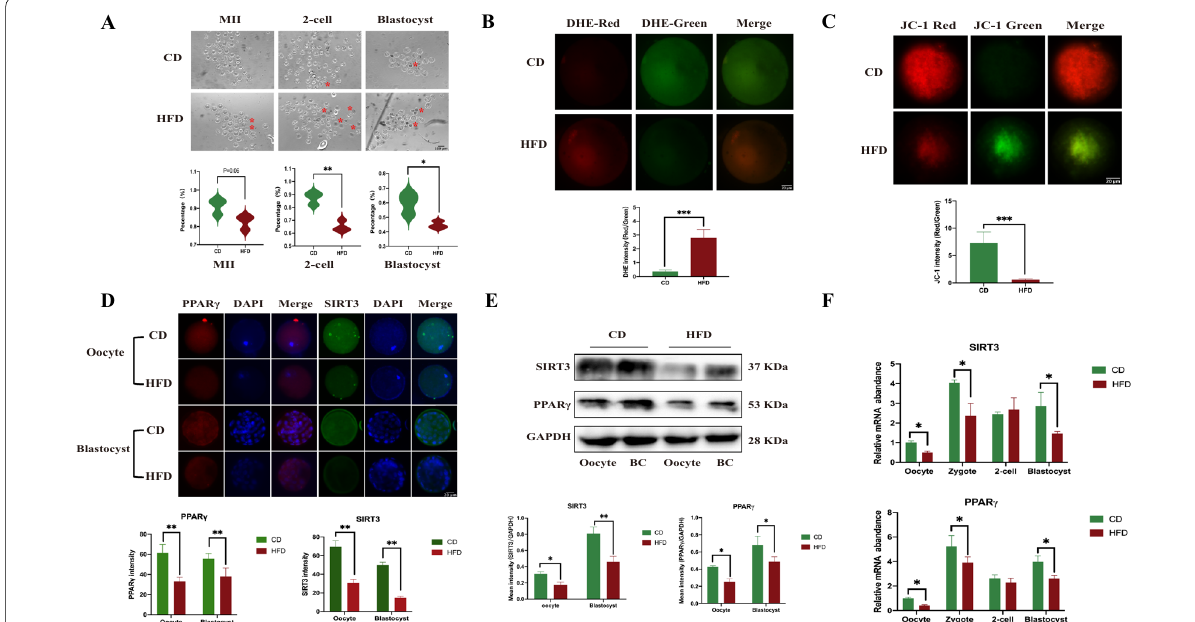
Fig. 2 Development potential in oocytes and preimplantation embryos of HFD mice. A Developmental status captures of oocytes and embryos from the HFD and CD groups. Red asterisks indicate abnormal oocytes or embryos. Bottom: Statistical results of developmental status (oocytes, n 90 for CD and n 77 for HFD; 2-cell embryos, n 80 for CD and n 54 for HFD; blastocysts, n 53 for CD and n 23 for HFD). B Reactive = = = = = = oxygen species (ROS) of MII oocytes stained with dihydroethidium from the HFD and CD groups. The red fluorescence intensity represents the level of ROS. Bottom: The statistical results are shown between the HFD and CD groups. C Mitochondrial membrane potential (MMP) of MII oocytes stained with JC-1 from the HFD and CD groups. The ratios of the red/green fluorescence intensity indicated the levels of MMP, and Bottom: The statistical results are shown between the HFD and CD groups. D Representative immunofluorescence results of SIRT3 and PPARγ in oocytes and blastocysts from the HFD and CD groups. E Western blot analysis of SIRT3 and PPARγ in oocytes from the HFD and CD groups. F: qPCR results of SIRT3 and PPARγ from oocytes to blastocysts between the HFD and CD groups. Throughout, n 20 in each group for IF analysis and n 3 in each = = group for WB or qPCR analysis. Data are presented as means SD. P values are calculated by Student’s t test. * p < 0.05, ** p < 0.01, *** p < 0.001. ns ± indicates not significant. Scale bars are shown in the lower right corner of the captures. HFD high-fat diet, CD control diet, BC